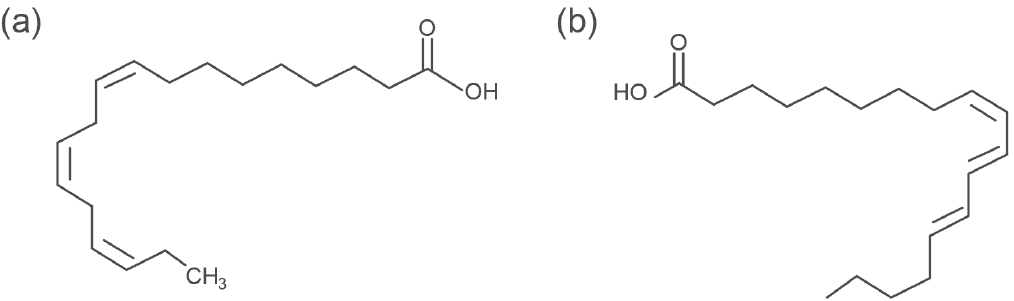
Figure 1. Conjugated and unconjugated double bonds of some components of drying oils: ( a ) linolenic acid in linseed oil; ( b ) α -eleostearic acid in tung tree oil.